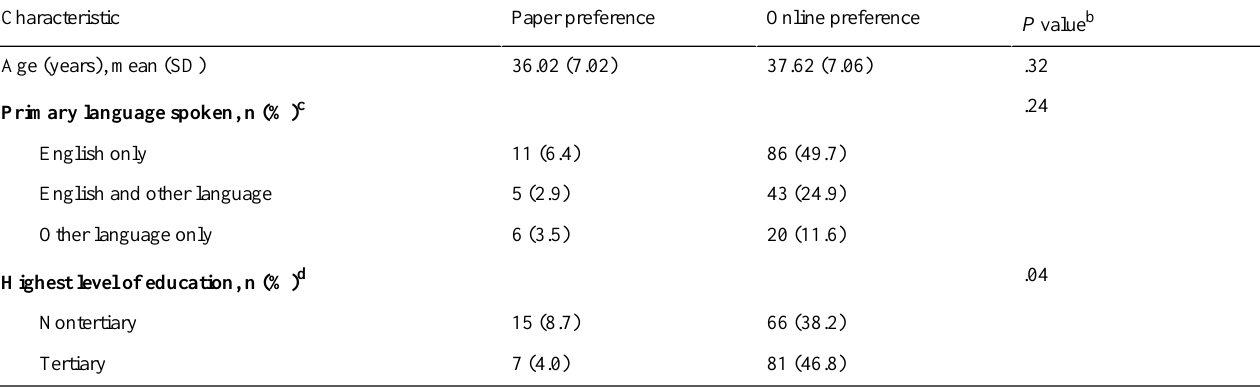
Table 3. Demographic characteristics by questionnaire modality preference in the EDC a group.